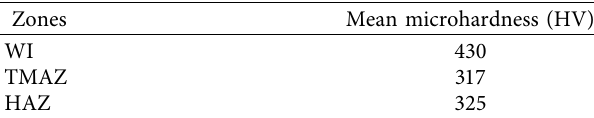
Table 5: Mean microhardness of different regions of